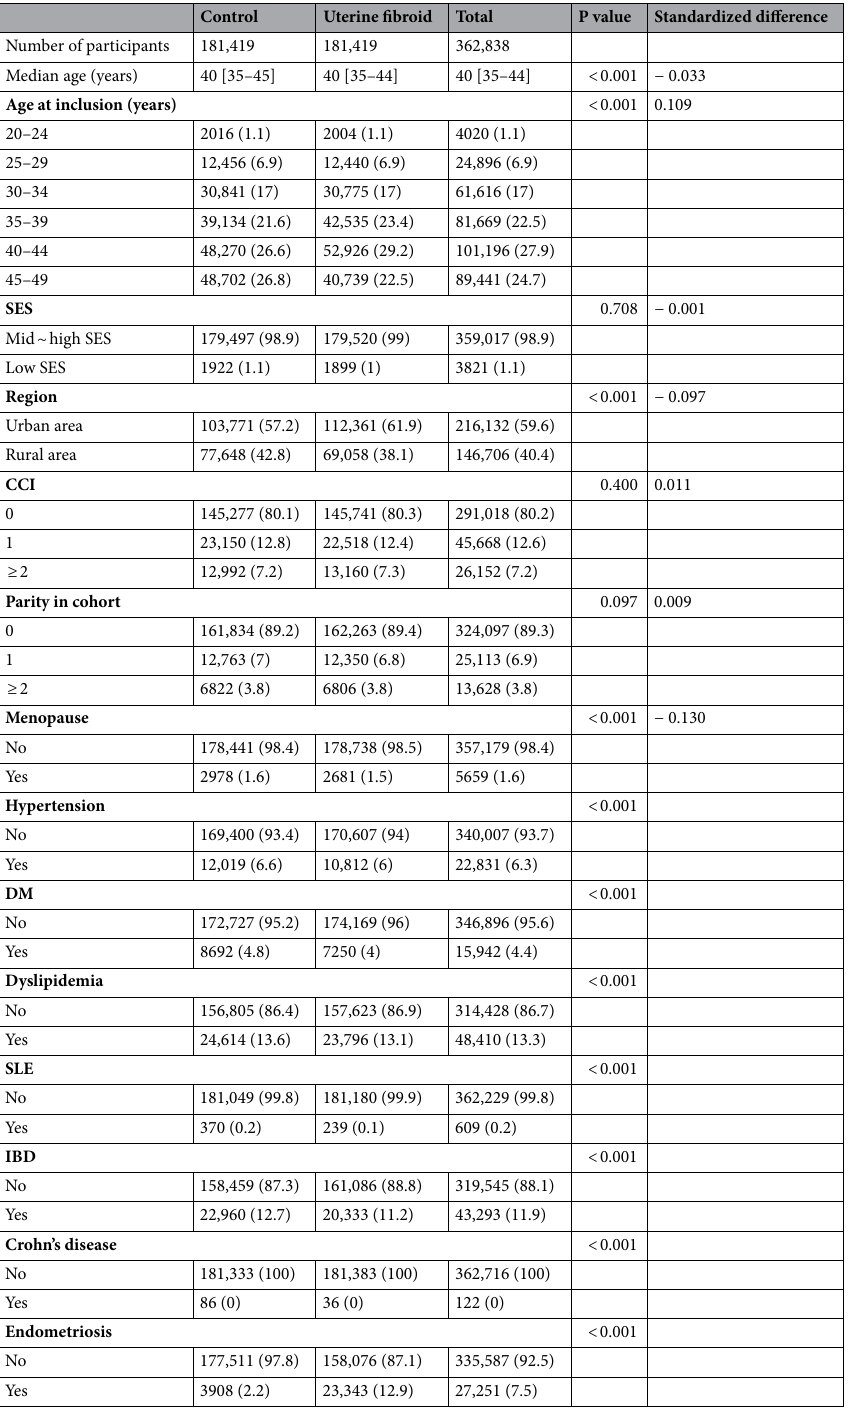
Table 1. Characteristics of women with uterine fibroid and the control group from the HIRA claim data. CCI Charlson comorbidity index, DM diabetes mellitus, IBD irritable bowel syndrome, SES socioeconomic status, SLE systemic lupus erythematosus. Data are expressed as the number (%) or median [25 percentile, 75